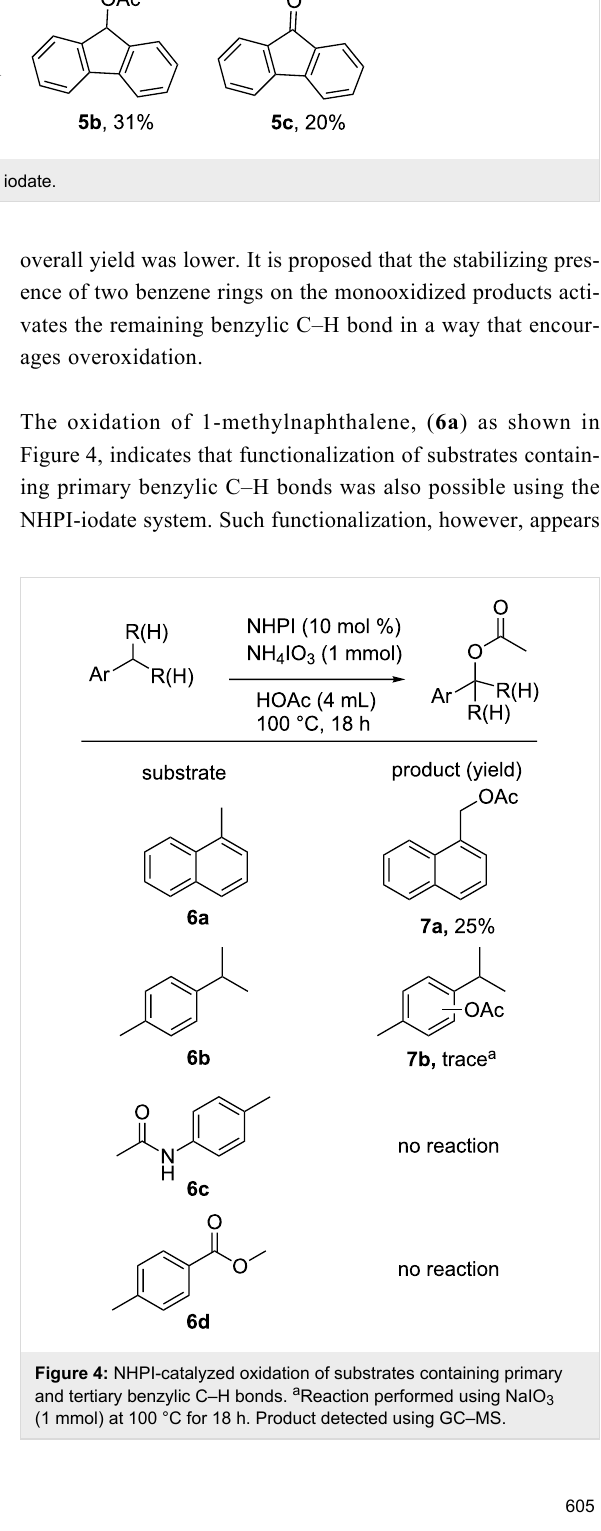
Figure 3: NHPI-catalyzed oxidation of di-benzylic C–H bonds mediated by iodate.